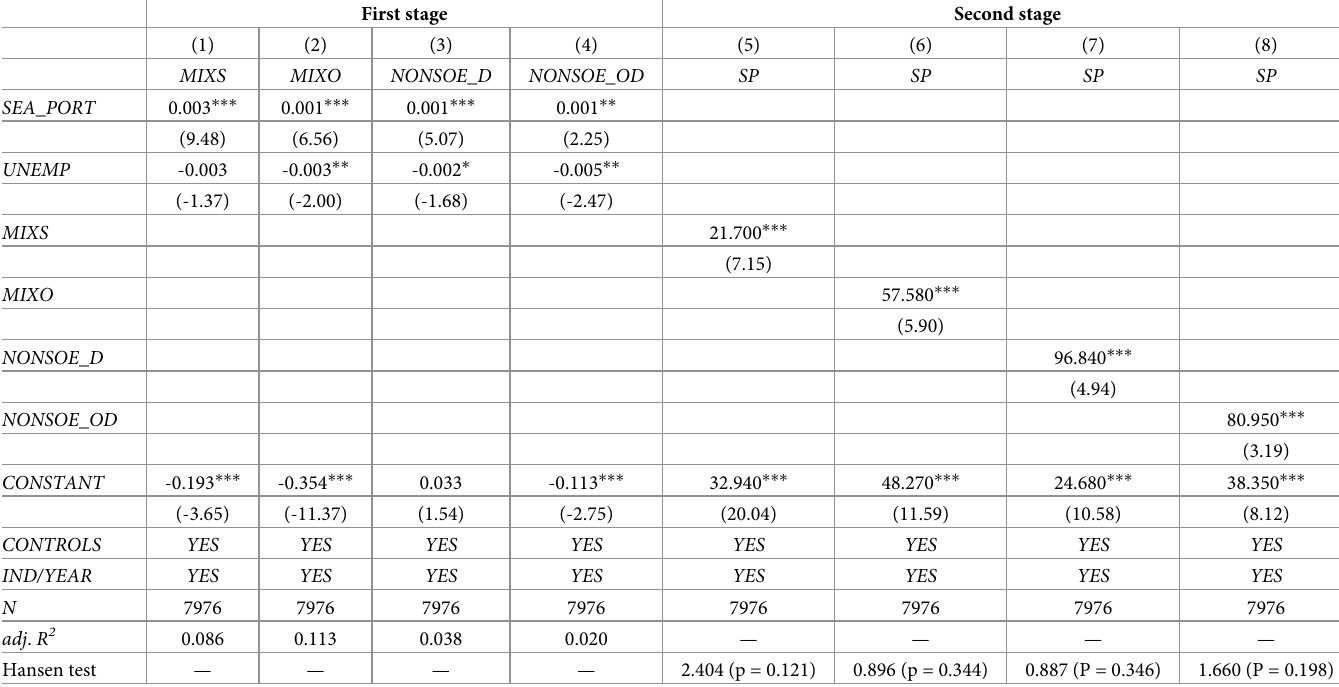
Table 4. The regression results of two-stage 2SLS.